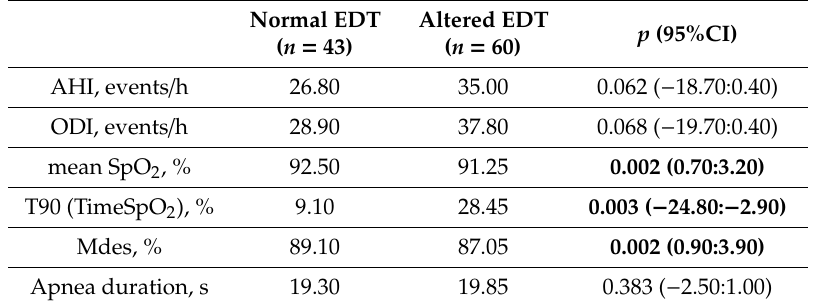
Table 3. Median of nCRP parameters according to EDT classification (altered vs.